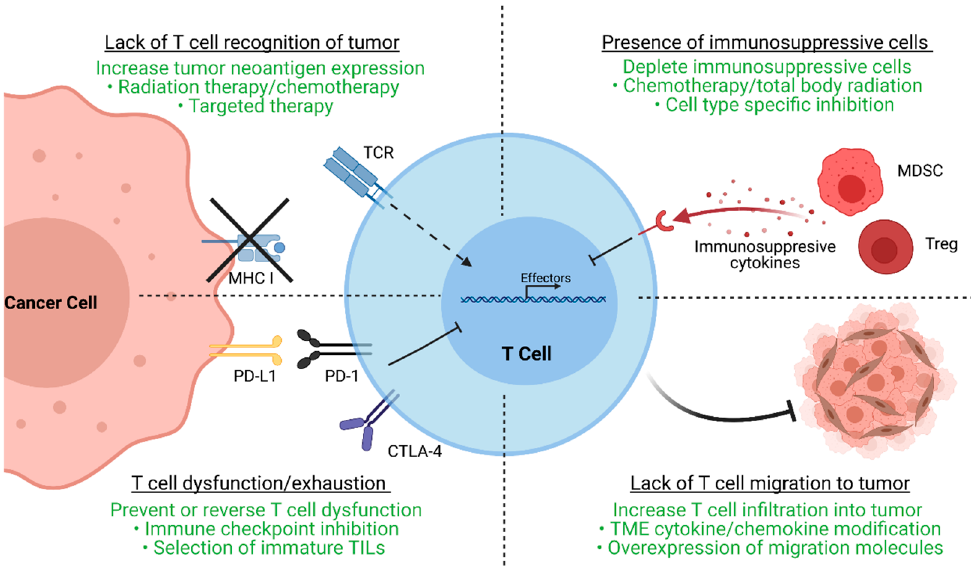
Figure 2. Major resistance mechanisms to TIL-ACT. This figure demonstrates four major resistance mechanisms to TIL therapy as well as strategies (highlighted in green) to overcome these mechanisms. Tumor cells may downregulate MHC molecules or neoantigen expression to avoid immune detection by neoantigen-specific T cells. Radiation therapy, chemotherapy, and targeted therapy are common ways to increase neoantigen generation and upregulate neoantigen presentation. Tumor cells and other components of the TME may upregulate checkpoint molecules such as PD-L1 to induce T cell exhaustion, a dysfunction state by which T cells cannot proliferate or secrete effector molecules. Exhausted T cells can regain effector function with immune checkpoint inhibitor treatment. Another way to bypass T cell exhaustion is by selecting for TILs that are less prone to exhaustion. Immunosuppressive cell types within the TME, such as myeloid-derived suppressor cells (MDSCs) or regulatory T cells (Tregs), can secrete factors that inhibit TIL function. These host immunosuppressive cells can be depleted prior to or simultaneously with adoptive cell transfer by chemotherapy or radiation therapy regimens as well as cell type specific inhibition. Lastly, the TME itself may pose barriers that exclude T cells and inhibit their migration. Experimental therapies that modify chemotactic and migratory pathways may restore or increase tumor infiltration by TILs. TIL (tumor-infiltrating lymphocytes); ACT (adoptive cell therapy); MHC (major histocompatibility complex); TME